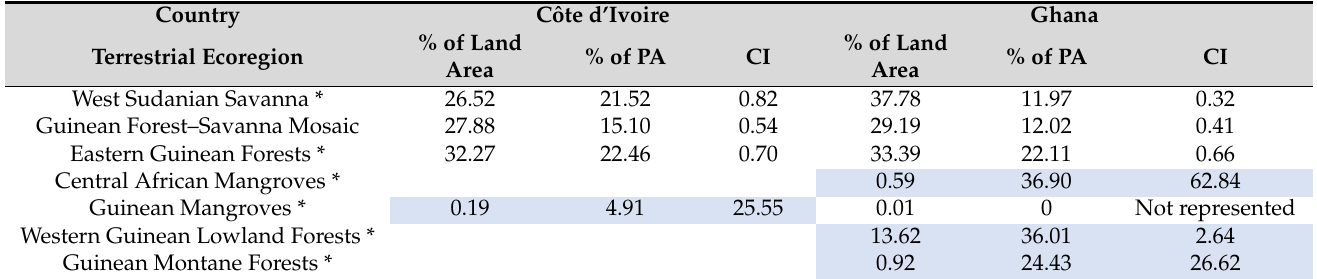
the Guinean mangroves and Guinean montane forests well (Table